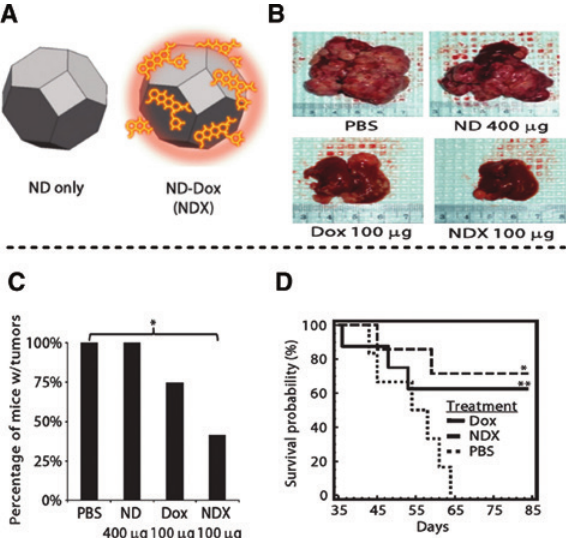
Figure 4: An illustration of using nanodiamonds as drug delivery